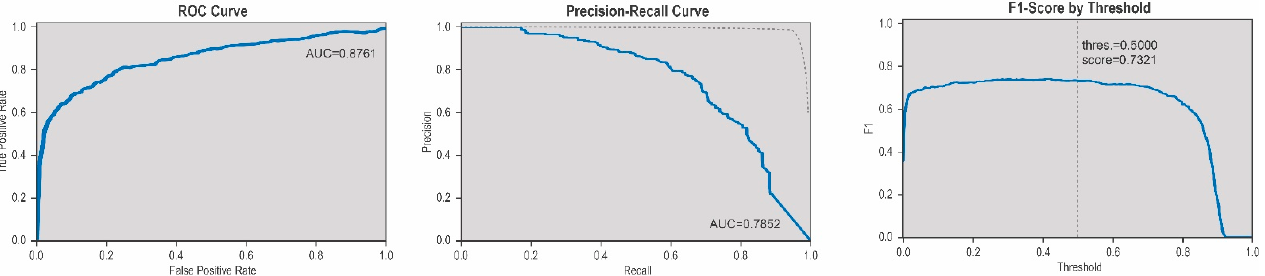
Figure 4. ROC Curve, Precision-Recall Curve, F1-Score. The ROC curve of the model shows an area under the curve of. The ROC-Curve shows and area und the curve (AUC) of 0.8761, the Precision-Recall Curve shows an AUC of 0.7852, while the threshold of 0.5 shows a F1-score of 0.7321.